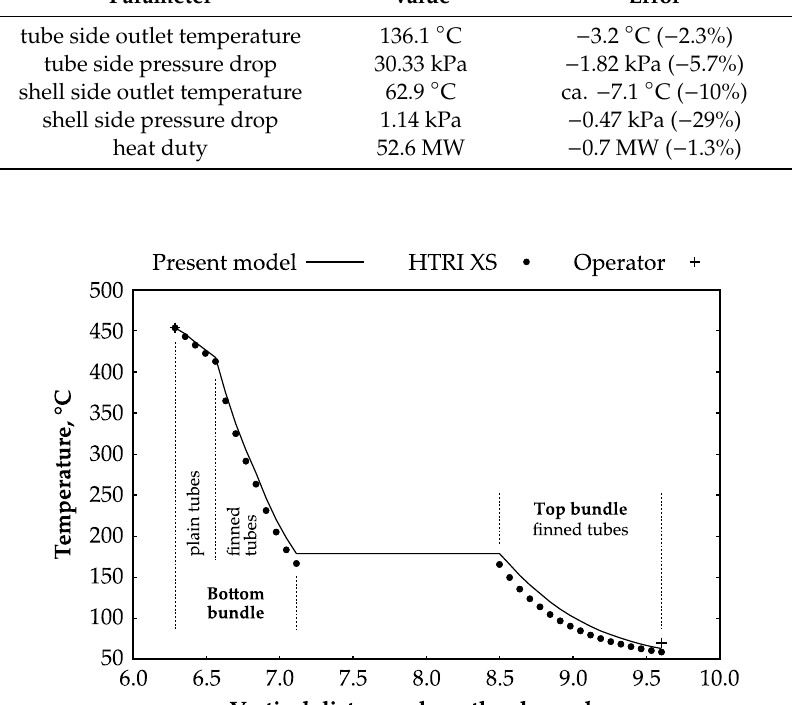
Figure 13. Comparison of the temperature distribution in the portion of the flue gas duct enclosing the two bundles, which was obtained using the present model, and the corresponding temperatures provided by the operator of the boiler and yielded by HTRI Xchanger Suite (“HTRI XS”). Vertical distance along the channel corresponds to the distance from the point denoted “y = 0 m” in Figure 9.